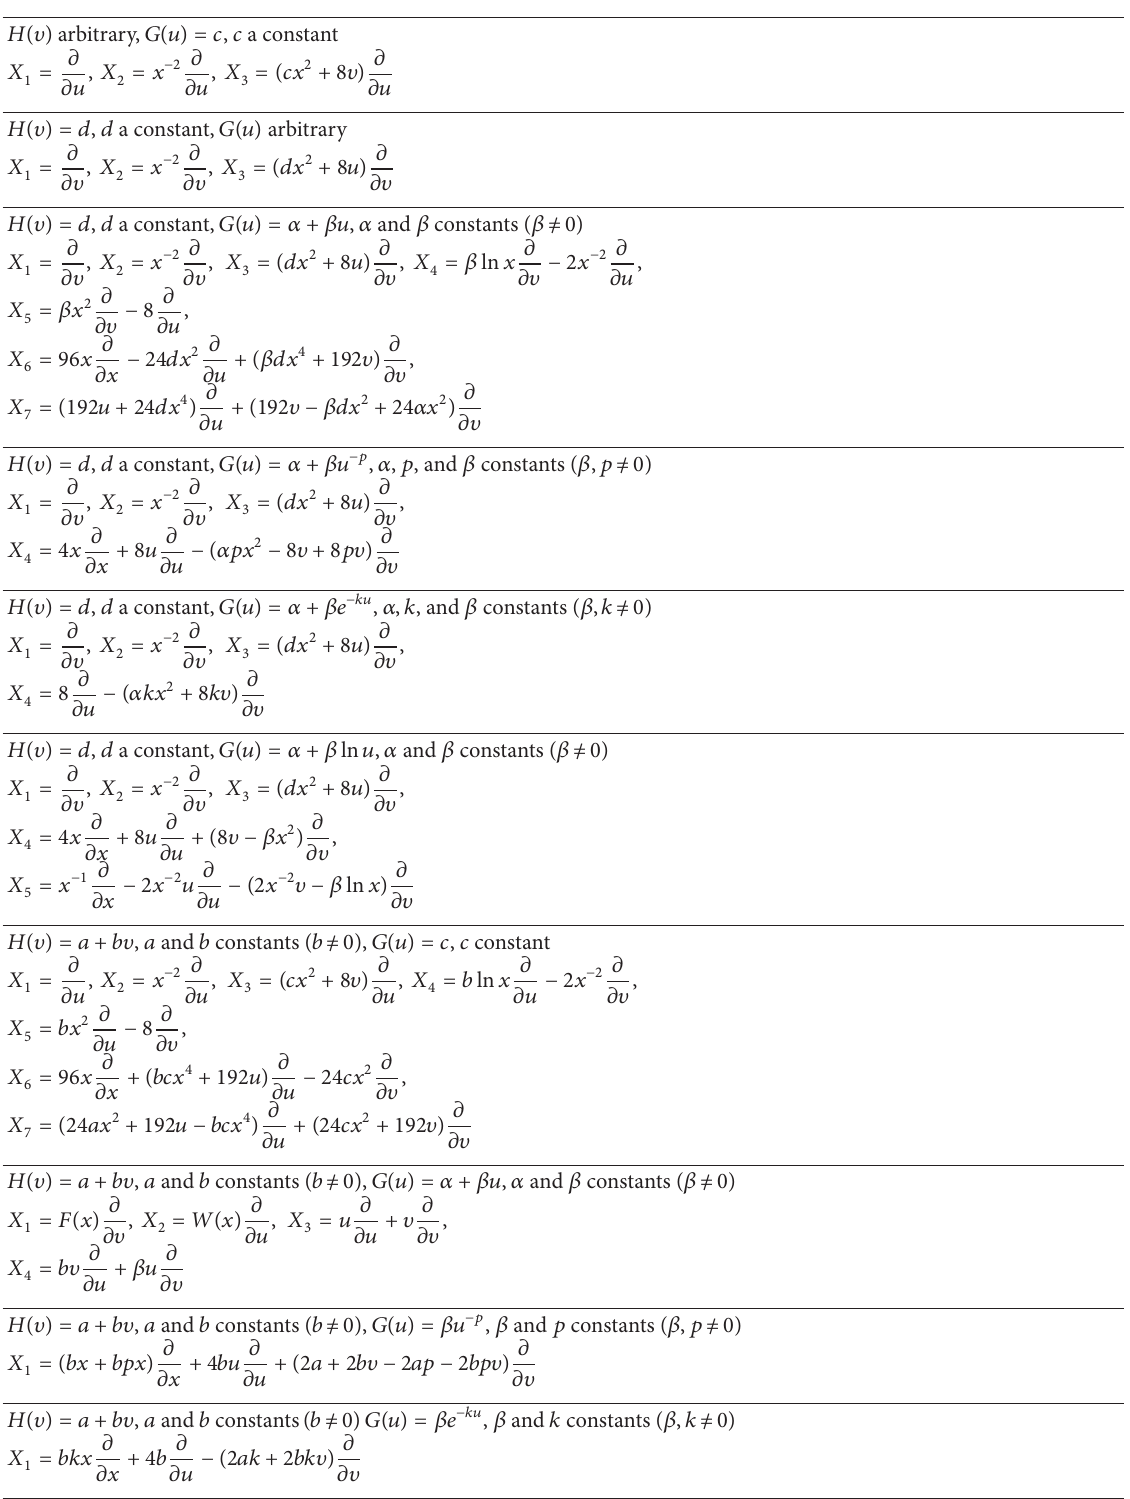
Table 4: Lie symmetries for 𝑛 = 3 , for various functions 𝐻(𝑣) and 𝐺(𝑢) . 𝐻(𝑣) arbitrary, 𝐺(𝑢) = 𝑐 , 𝑐 a